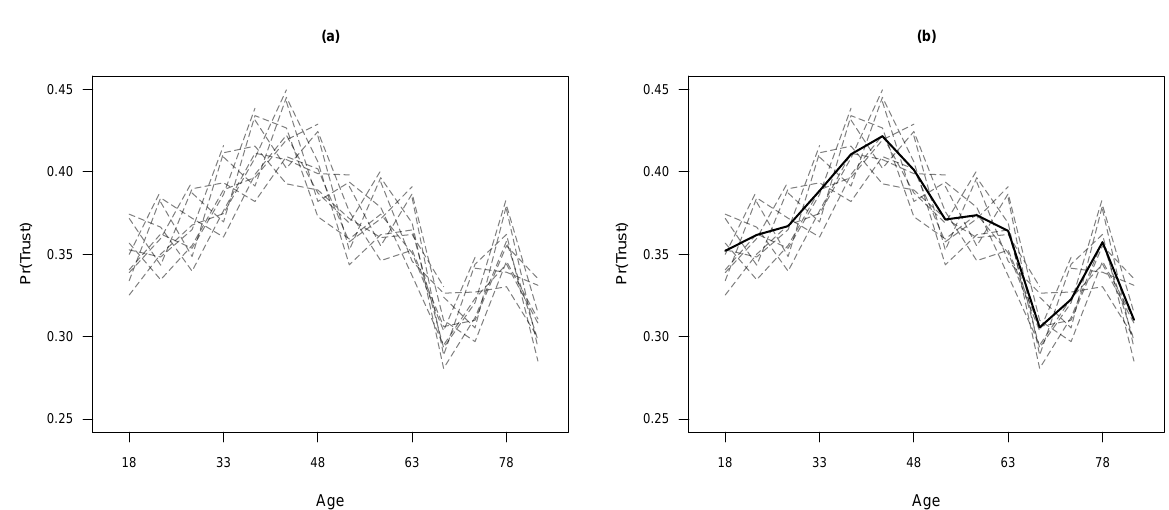
Figure6: Spaghetti plot of local diachronic age curves. Notes: (a) displays a spaghetti plot of local diachronic age curves. (b) displays local diachronic age curves overlaid with the (overall) diachronic age curve. Calculations α i + π i + k − I for i = 1, . . . , I in each cohort k . Local curves are for the local curves are based on θ 1 ( i − i ∗ ) + shown with dashed lines, whereas the overall curve is shown with a bold solid line. Only cohorts with three or more age groups are displayed. All estimates are based on a diachronic L-APC logistic regression model. (cid:101) (cid:101) Outcome is social trust, coded so that 1 = “can trust” while 0 = “can’t be too careful” or “depends.” Results adjusted using sampling